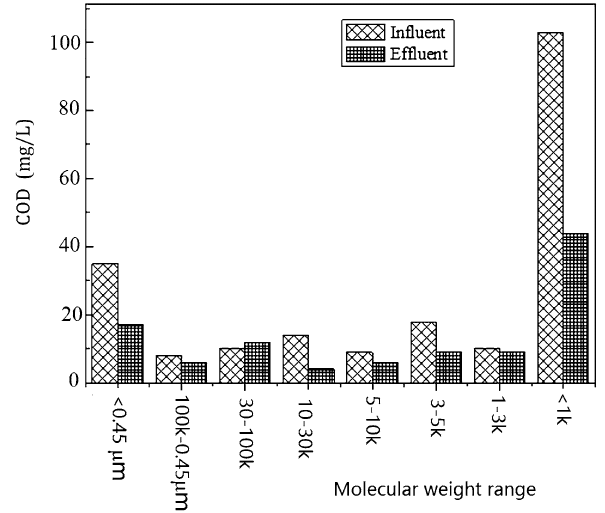
Fig. 3 Molecular weight distribution of influent and effluent organic matter